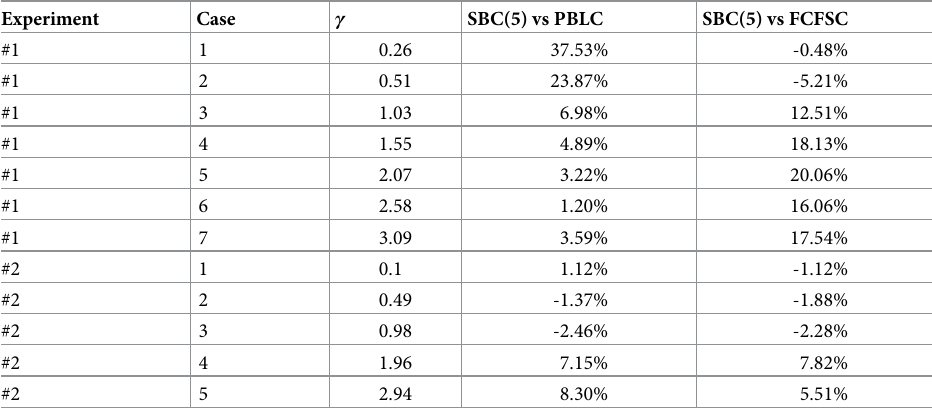
Table 6. Comparison of average revenue between seat-based control, PBLC and